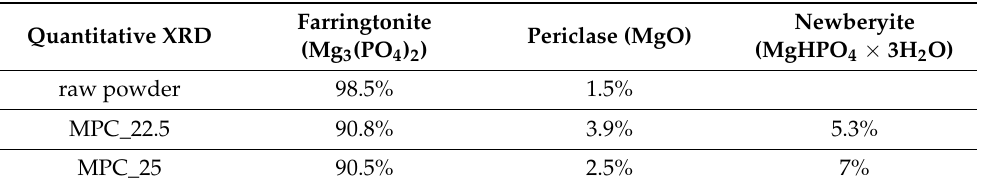
Table 3. Results of the quantitative X-ray Diffraction Analysis (XRD) of the cement raw powder and of the cement formulations after 3 h of setting.